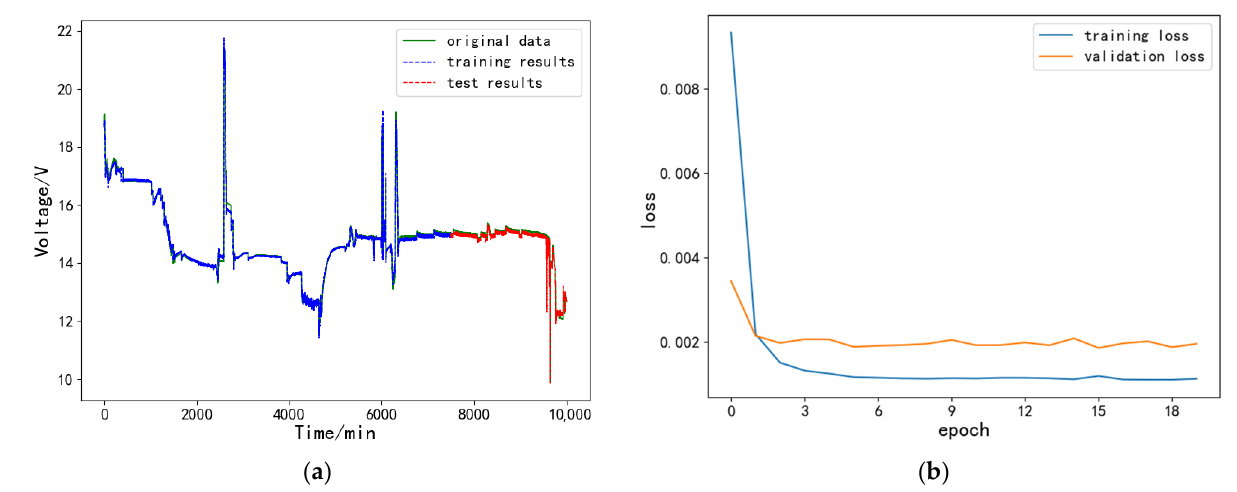
Figure 12. Prediction results of the original GRU model. ( a ) Model training and prognosis results; ( b ) training loss during the training phase.